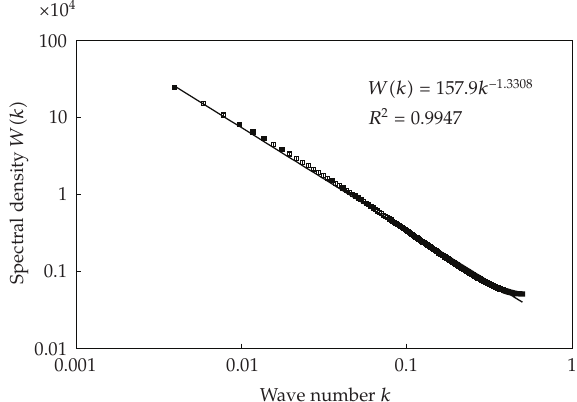
Figure 2: A log-log plot of the wave spectrum relation based on the inverse power function. (cid:3) Note that a sample, with N (cid:8) 512, can be produced by taking D f (cid:8) 1.6654 and ρ 1 (cid:8) 1000 in (cid:3) 2.2 (cid:4) . The spectral exponent of this data set is computed as β ≈ 1 . 3308, thus (cid:3) 2.7 (cid:4) yields a dimension estimation D ∗